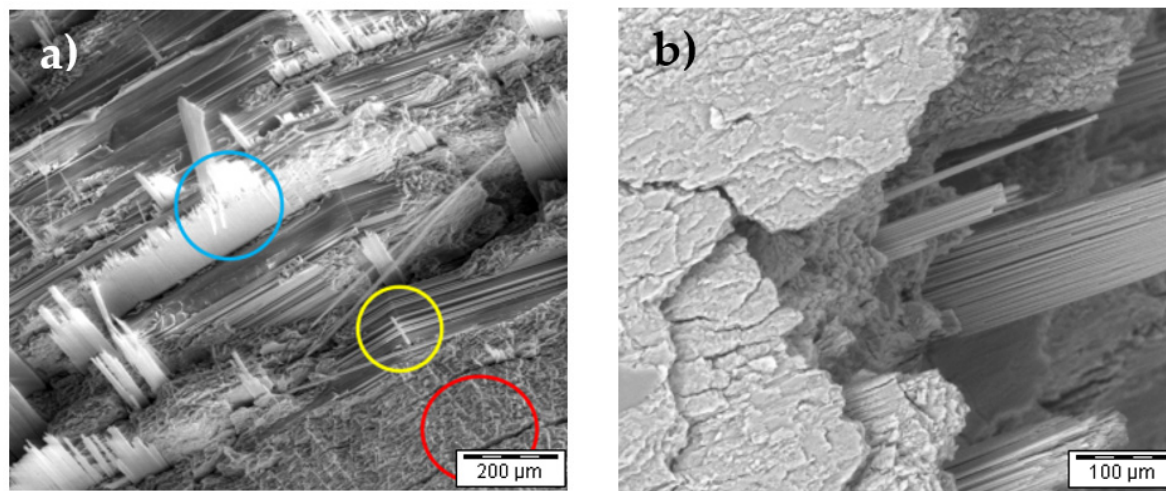
Figure 8. EDX measured at 6 points (highlighted points 1–6), 3× expected α -HH (1,2,3), 2× dihydrate (4,5) and 1× β -HH (6).